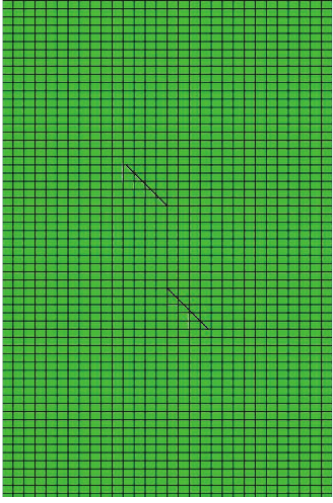
Figure 7: The numerical model of crack extension trajectory under uniaxial